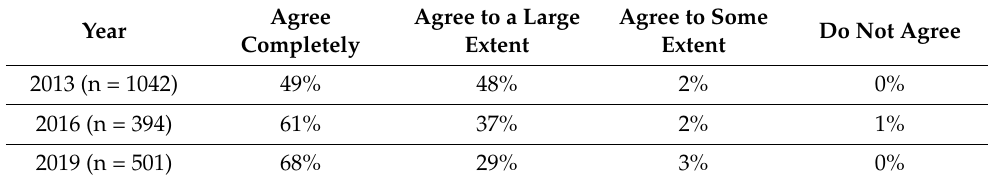
Table 3. Teacher responses to the statement ‘The test as a whole is good’ (2013, 2016 and 2019).